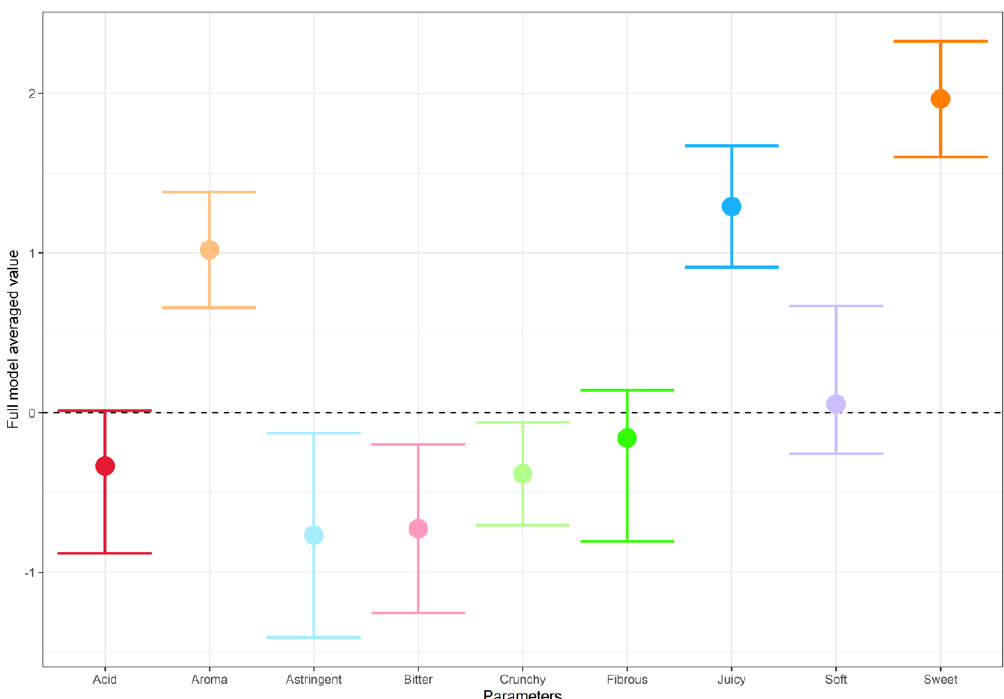
Figure 5. Model averaged parameter values for peach characteristics, based on only the best models (delta value < 2). The parameter value represents the average change in rating based on that parameter moving from ‘No’ to ‘Yes’, the dashed line indicates no effect. Thus, for example, sweetness had a consistently positive effect on hedonic rating whereas bitterness had a consistently negative effect.